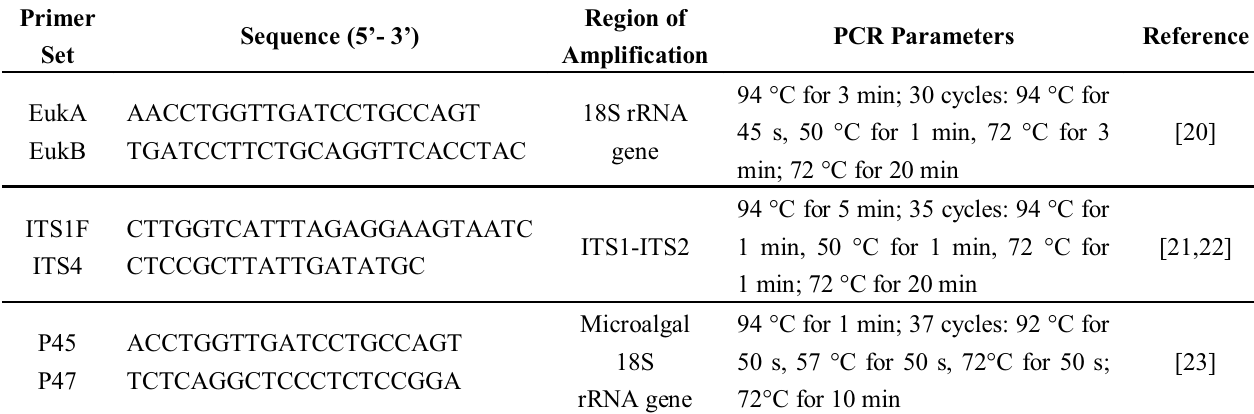
Table 1. PCR primers used to amplify universal 18S rRNA, Internal Transcribed Spacer (ITS) and microalgal 18S regions of ribosomal RNA genes from eukaryotic microorganisms, and their respective PCR cycling